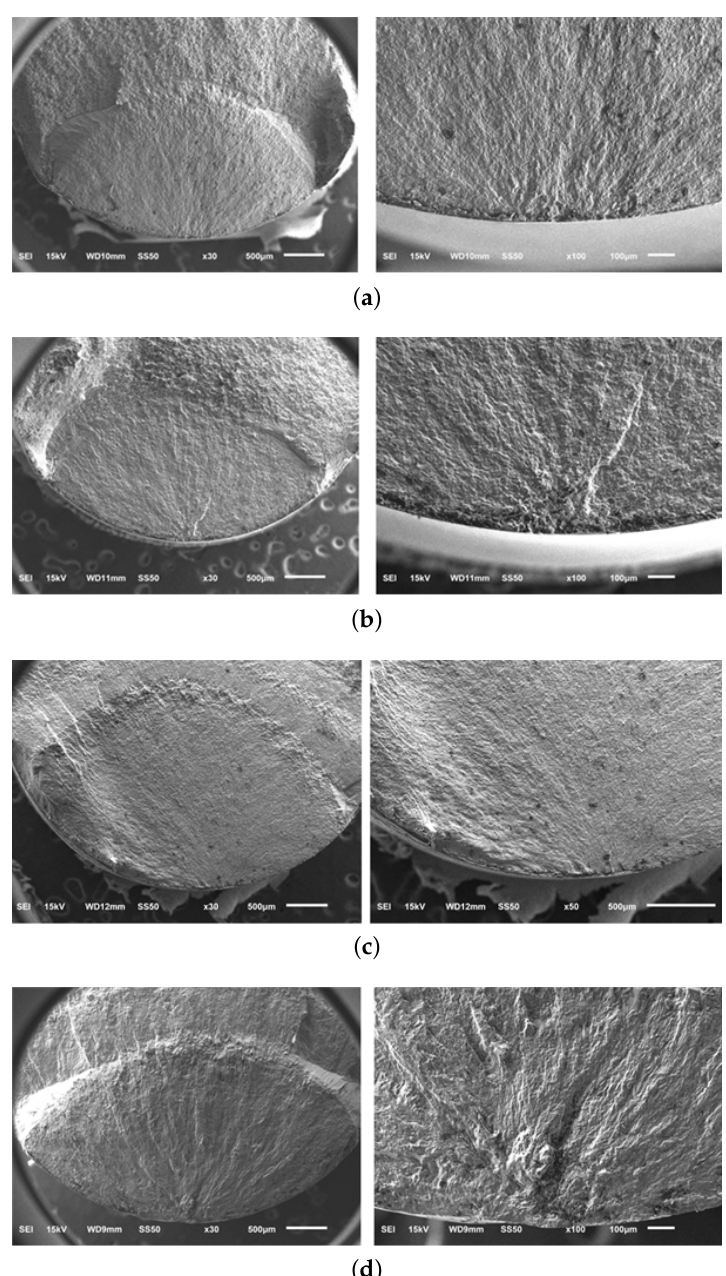
Figure 18. SEM micrographs of ultrasonic fatigue test. ( a ) Material sample A; ( b ) Material sample A-H; ( c ) Material sample B; ( d ) Material sample